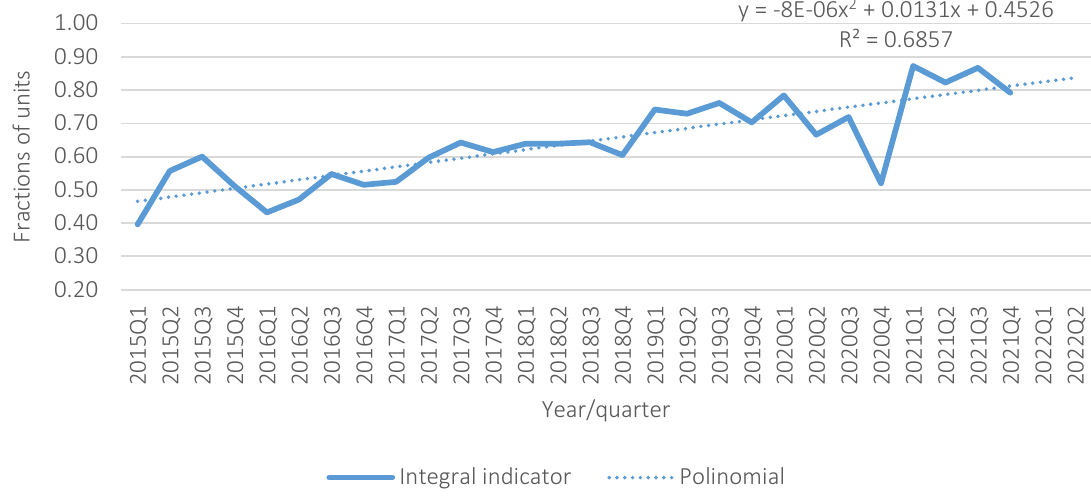
Figure 2. Dynamics of the integral indicator of Ukraine’s economic security during 2015–2022